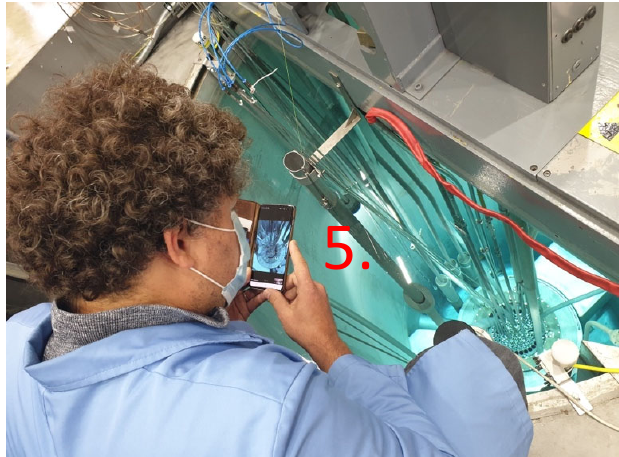
Figure 8 We used smartphones with video conference software as portable cameras.